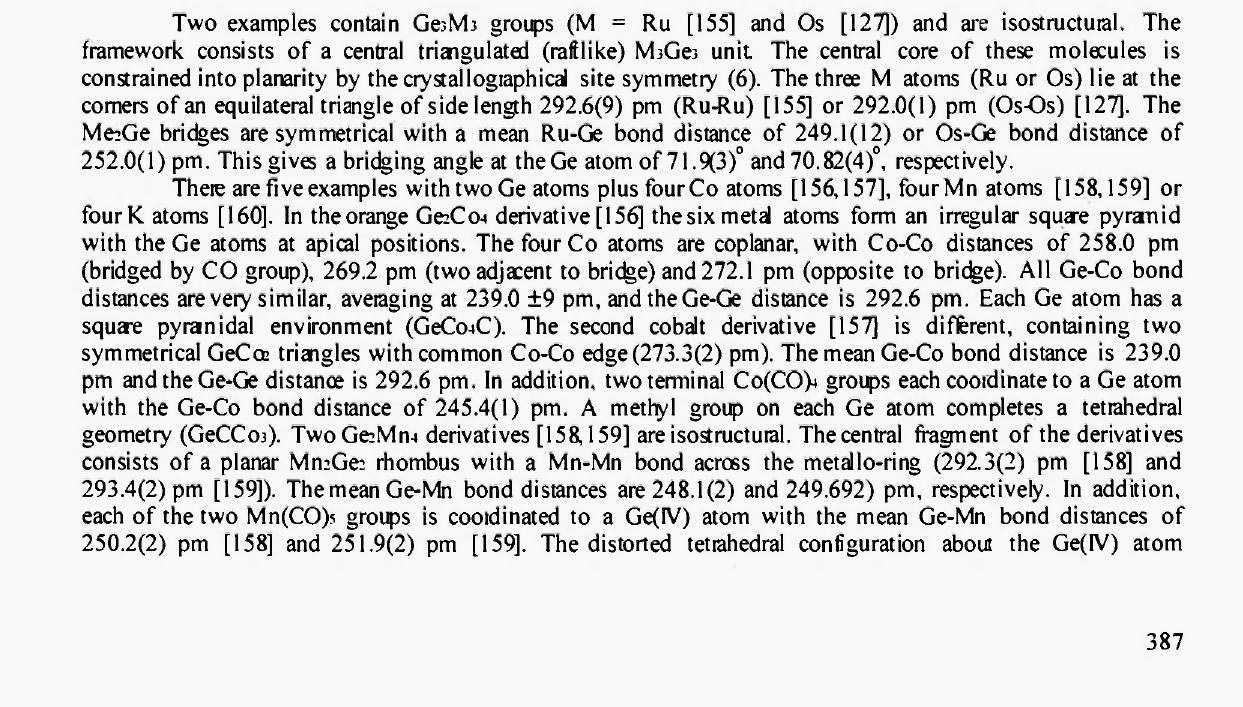
Fig. 11. Structure of |Cu(PhjGeCH 2